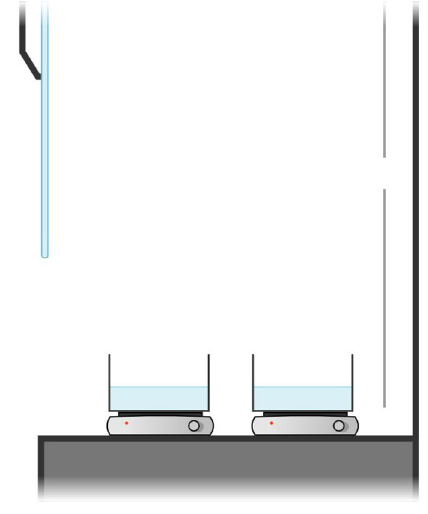
Fig. 3 Schematic of open system set up